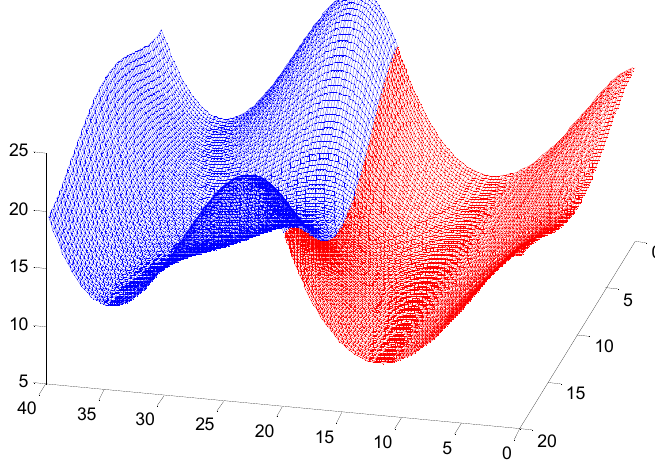
Figure 4. G 1 smooth continuity of two S- λ surfaces in the u direction.